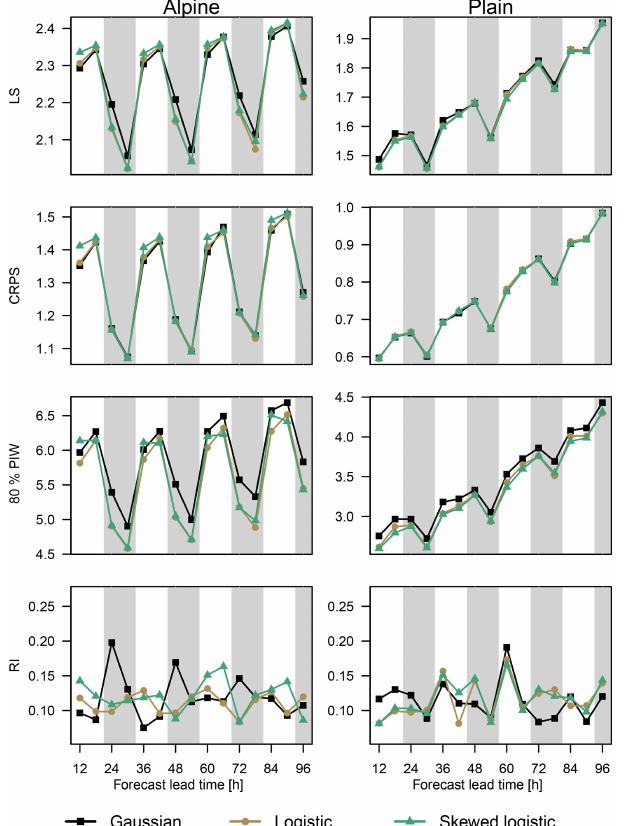
Figure 3. Performance measures at the selected Alpine site (left) and plain site (right) for all three models (Gaussian: squares; lo- gistic: circles; skewed logistic: triangles). From the top down, the LS, CRPS, 80% PIW, and RI are shown, and are evaluated for all forecasts + 12 to + 96h ahead. Nighttime forecasts (00:00 and 06:00UTC) are highlighted using vertical gray bars. Please note that the displayed range on the ordinate differs between the left and right column, except for